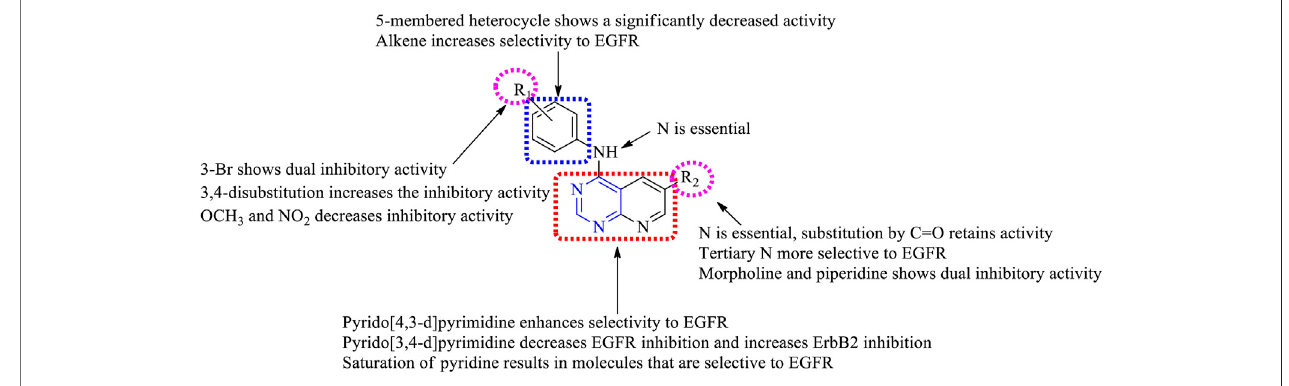
FIGURE 5 | Summary SAR of disubstituted